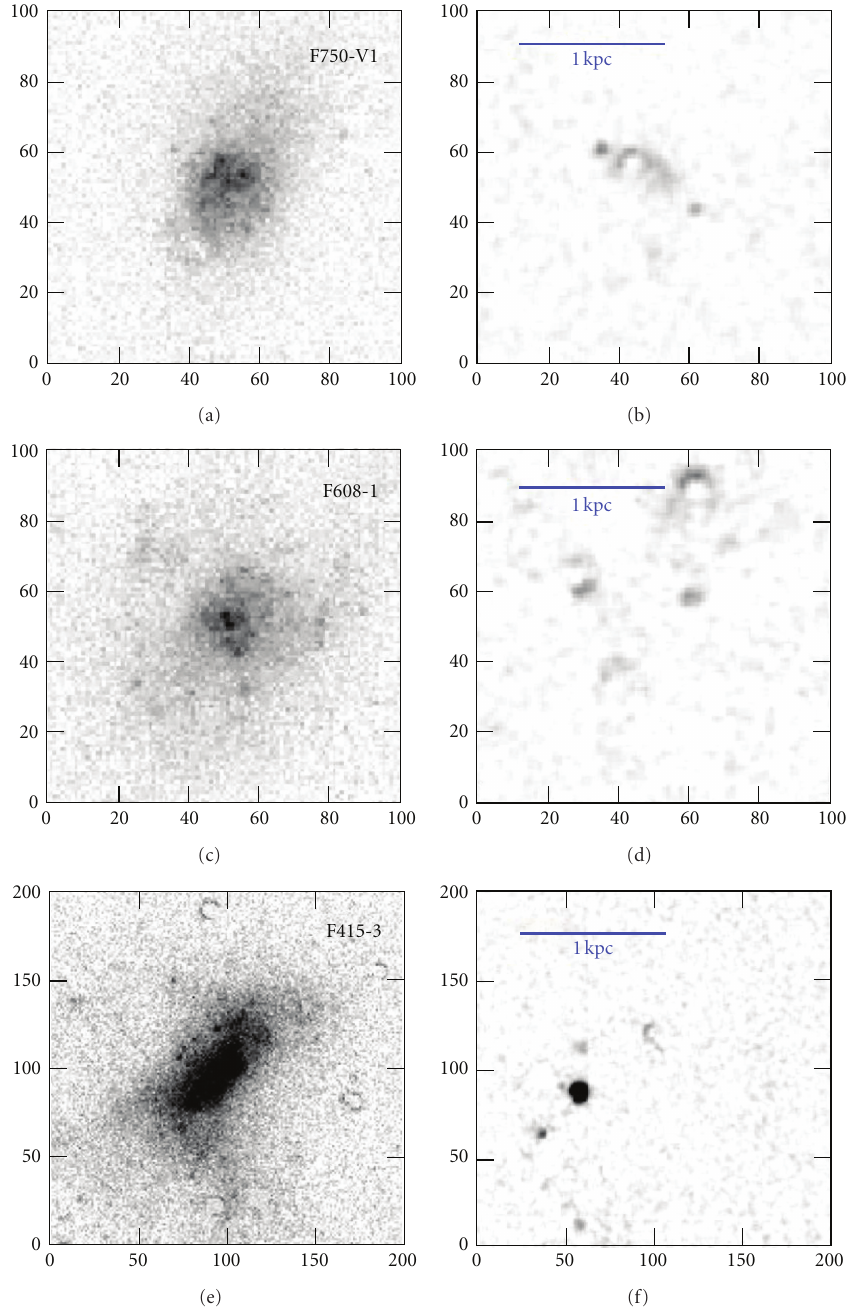
Figure 12: Three examples of H α maps compared to V images ( V on the left, H α on the right). While on occasion HII regions are seen in the V images (e.g., the brightest knot in D495-2), in most cases the H α emission is not visible in the optical images.